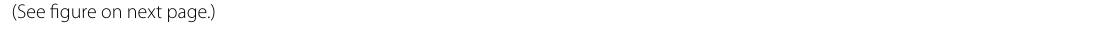
(See figure on next page.) Fig. 9 Crustal structure models. a The blue region is the area where granite is present in the lower crust, as noted by Ishikawa (2017). The crustal structure of this region is Model B. The crustal structure of the other regions is Model A. The continuous dotted lines denote depth (km) contours to the top of the subducted PAC slab (Iwasaki et al. 2015; Lindquist et al. 2004). b The crustal structure of Model A is shown. The upper crust is granite, and the lower crust is gabbro. The thickness of the upper crust is 18 km, and the depth of the Moho discontinuity is 30 km. Five cases are assumed, depending on the type of rock exposed at the surface and the thickness of the sedimentary layers. The depth of the basement rocks is based on the Shallow and deep layers combined model (SDLCM) (NIED 2019). Rock thermal conductivity and crustal heating values are as noted. c The crustal structure of Model B is shown. The upper crust and lower crust are granite. As in Model A, five cases are assumed, depending on the type of rock exposed at the surface and the thickness of the sedimentary layer. d The crustal structures of Model C and Model D are shown. The crustal structure of Model C is based on Tanaka (2009). The thermal conductivity of the rock is assumed to be constant. The crustal structure model D is based on Okubo et al. (1998). The upper crust is granite, and the lower crust is gabbro. The thickness of the upper crust is 18 km, and the depth of the Moho discontinuity is 30 km. Rock thermal conductivity and crustal heating values are as